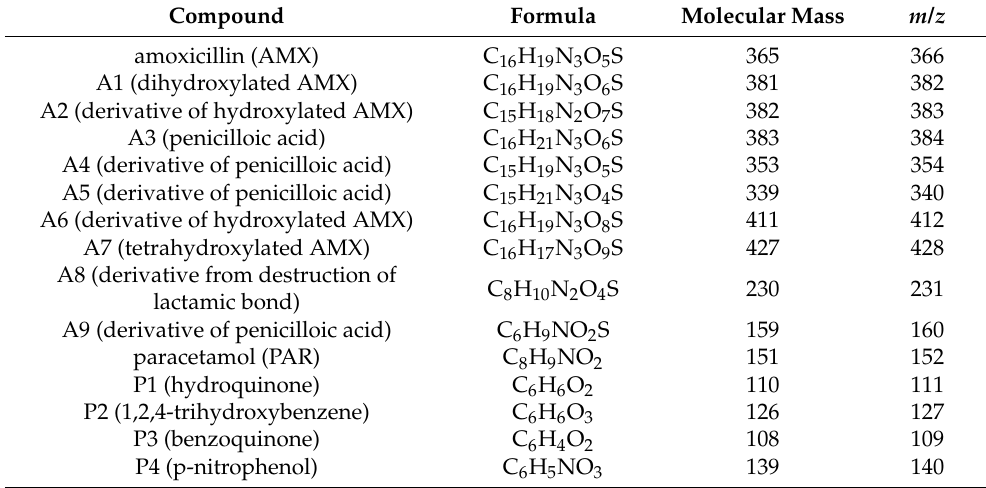
Table 3. Amoxicillin and paracetamol protonated degradation products monitored by LC–MS under SIM acquisition mode. Compound